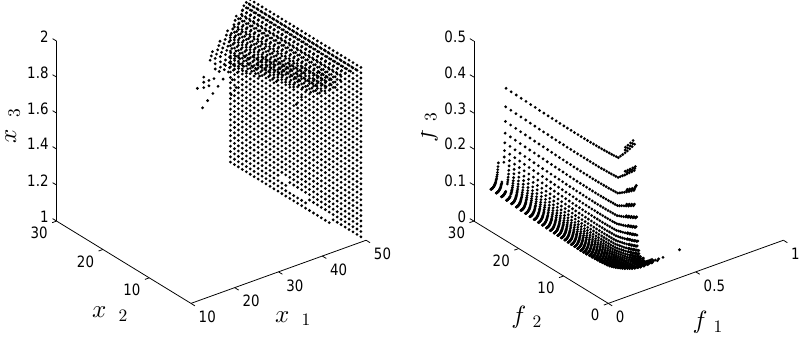
Figure 4. Approximation of the optimal solutions and their worst-case image found by GCM.